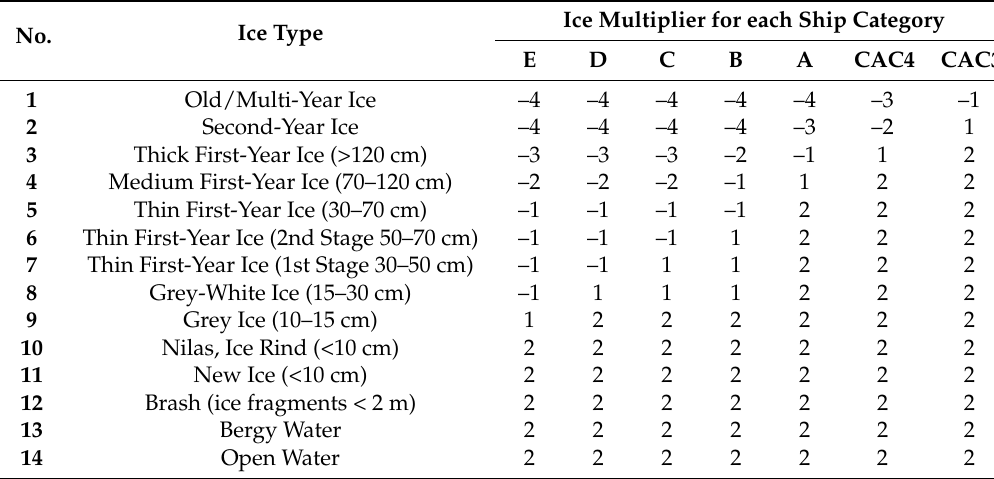
Table 1. Ice Multiplier (IM) based on ship types (Source: